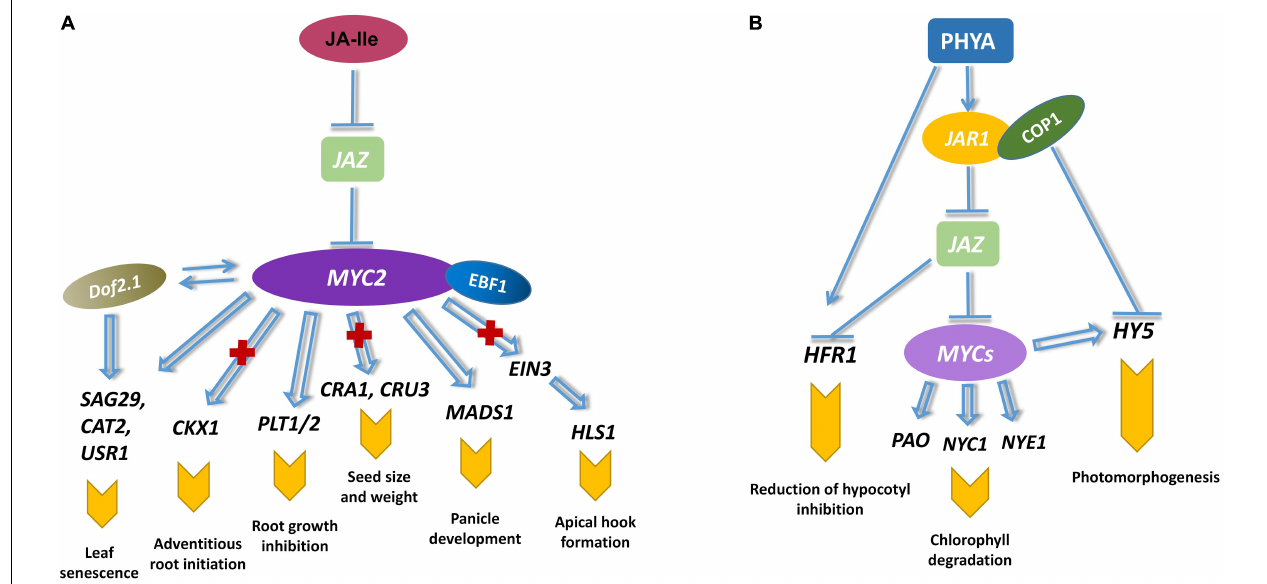
FIGURE 3 | MYC2 regulates plant growth and photomorphogenesis. (A) MYC2 mediates JA-regulated root growth and meristem development. MYC2 inhibits adventitious root initiation by reducing the expression of CKX1 (Dob et al., 2021). JA-induced division and stem cell differentiation in meristematic tissue is mediated by MYC2, which interacts with PLT to suppress the expression of PLT-targeted genes (Chen et al., 2011). MYC2 restrains seed development by regulating the expression of seed storage protein CRA1 and CRU3 (Gao et al., 2016). MYC2 and EIN3 additionally controlled apical hook development by interacting with EBF1 and repressing the expression of HLS1 (Zhang et al., 2014). Senescence-associated genes are mutually enhanced by MYC2 and Dof proteins (Zhuo et al., 2020). MYC2 accelerates leaf senescence by raising the transcription of SAG29 , CAT2 , and USR1 (Qi et al., 2015b; Zhang Z. et al., 2020). (B) MYCs are involved in the photomorphogenesis of plants. PHYA regulates the downstream of JA signaling and ultimately affects the activation of MYCs (Chico et al., 2014). PHYA control the hypocotyl inhibition and chlorophyll reduction through JA-mediated HFR1 and HY5 (Chakraborty et al., 2019). MYCs regulate JA-induced Chl degradation by directly activating some Chl catabolic genes ( PAO, NYC1, NYE1 ) (Zhu et al.,